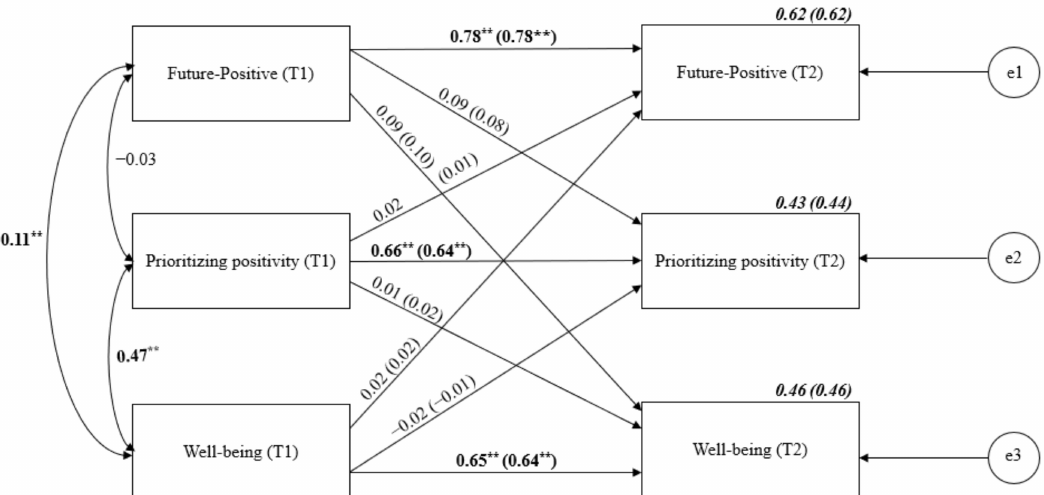
Figure 5. Cross-lagged panel analysis of Future-Positive TP, prioritizing positivity and well-being. Notes: Path entries are standardized estimates. T1 and T2 indicate the time when data were collected (Time 1 or Time 2, respectively). Estimates for the corresponding model with age and gender controlled are given in brackets. e1–e3 refers to the residual error or error variance that causes response variation in observed variables. ** p < 0.01.